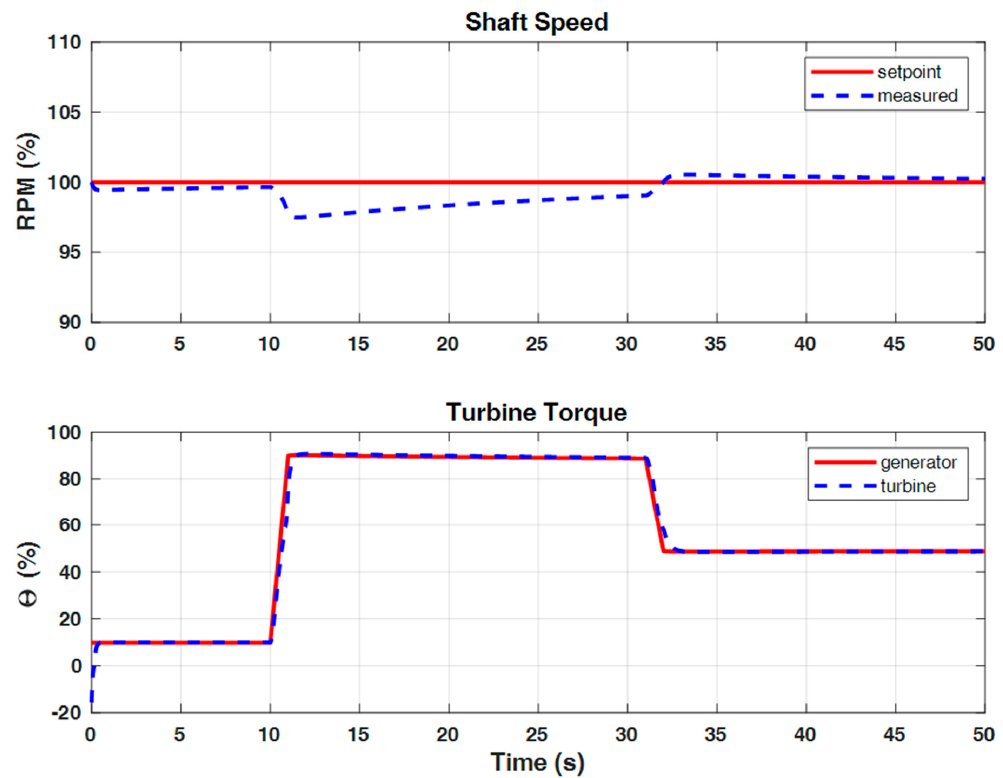
Figure 8. Closed-loop response to rising and falling steps.